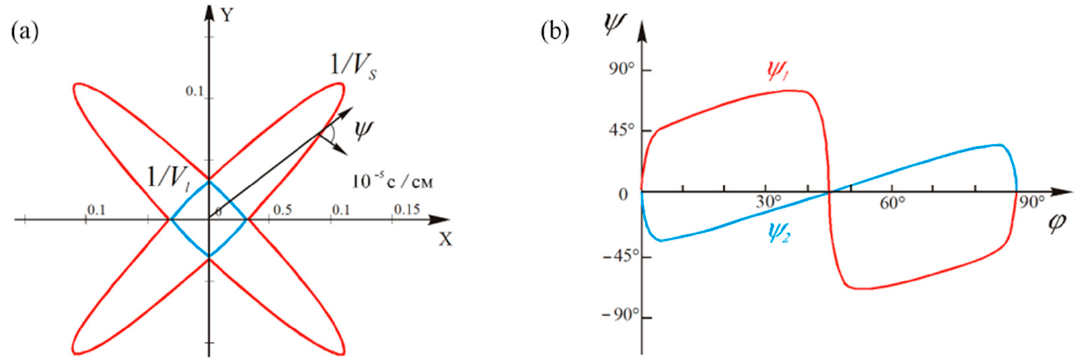
Figure 1. Acoustic characteristics of a paratellurite crystal: ( a ) distributions of the inverse phase velocities of acoustic modes in the XY plane and ( b ) distributions of the walk-off angles of the acoustic modes’ energy in the XY plane.